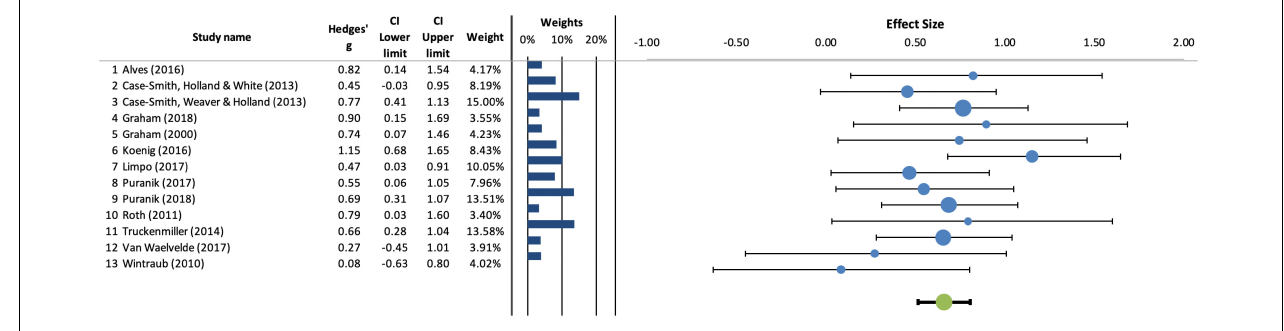
FIGURE 2 | Effectiveness of handwriting interventions compared to conditions involving either no instruction or instruction unrelated to